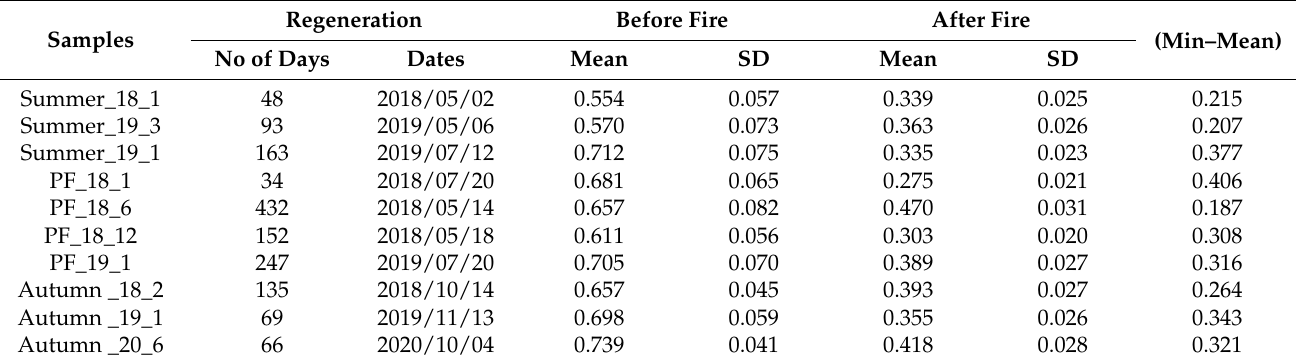
Table 3. Each polygon utilized in the NDVI studies was given its own set of data.